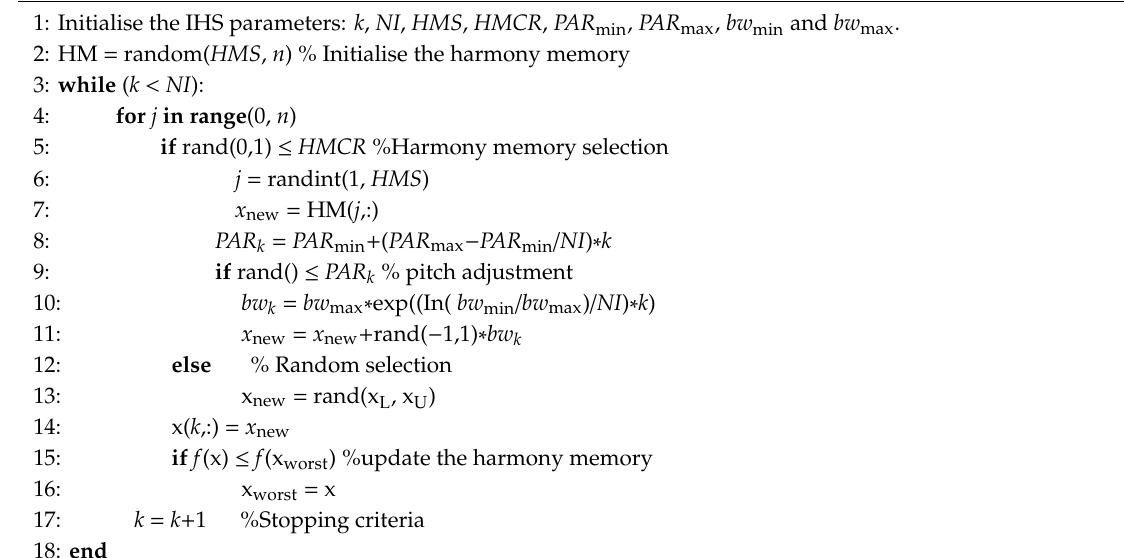
Algorithm 1. Improved Harmony Search Algorithm.